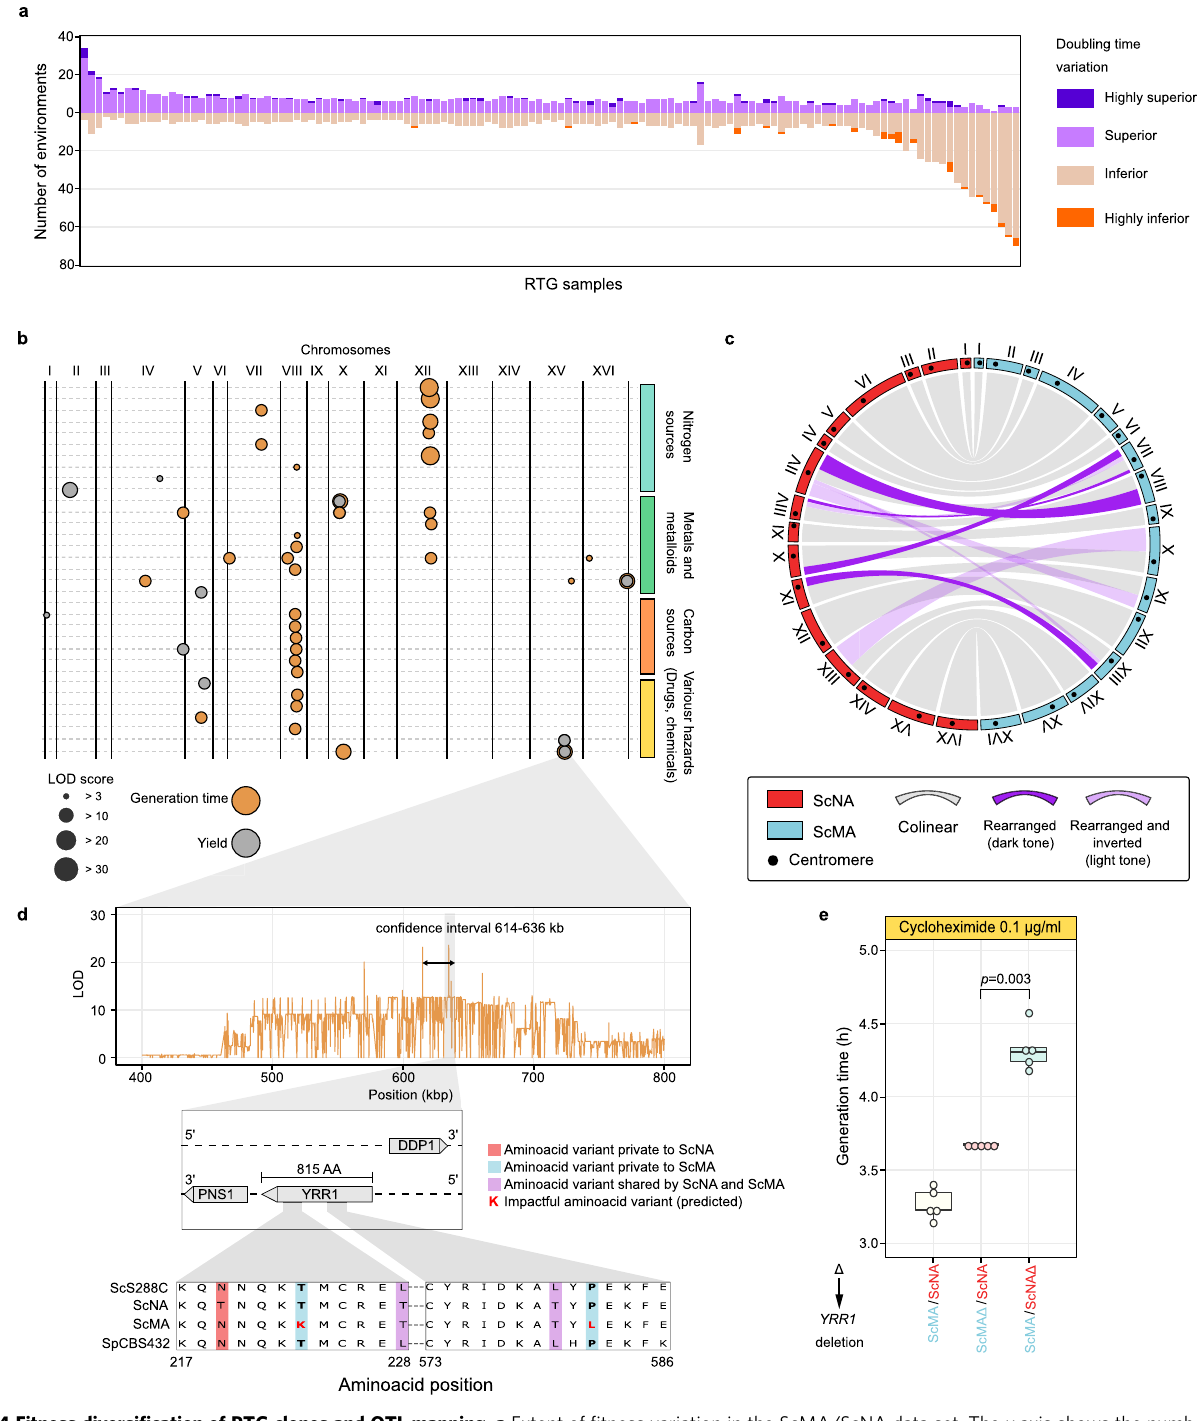
Fig. 4 Fitness diversi fi cation of RTG clones and QTL mapping. a Extent of fi tness variation in the ScMA/ScNA data set. The y axis shows the number of environments in which the cell doubling time of the RTG clone is superior or inferior compared with the ScMA/ScNA parent hybrid. b QTLs mapped across the environments. Only conditions where QTLs were detected are reported. c Circular plot representing the rearrangements between the two subgenomes of the ScMA/ScNA hybrid. Regions are considered inverted if they do not resemble the ancestral centromere – telomere orientation. d Linkage scan for growth in media containing cycloheximide. Zoom-in on chromosome XV QTL and the two highly conserved regions of YRR1 with two amino-acids substitutions predicted to be deleterious. e Boxplot of doubling times in cycloheximide for the parental ScMA/ScNA strains ( fi ve replicates) and the two hemizygous strains ( fi ve replicates). The deletion of either allele reduces growth in cycloheximide compared with the WT, underlying YRR1 haploinsuf fi ciency in this background. The deletion of the ScNA allele is signi fi cantly worse (one-tailed Wilcoxon rank-sum test p value = 0.003) than the ScMA. The boxplot is de fi ned as follows: the box is delimited by the fi rst quartile (Q1) and the third quartile (Q3). The line that separates the box is the median. Whiskers are de fi ned as: upper whisker = min(max( x ), Q3 + 1.5 × IQR); lower whisker = max(min( x ), Q1 – 1.5 × IQR), where: x is the data, Q1 is the fi rst quartile, Q3 is the third quartile and IQR is the interquartile range (IQR = Q3 −